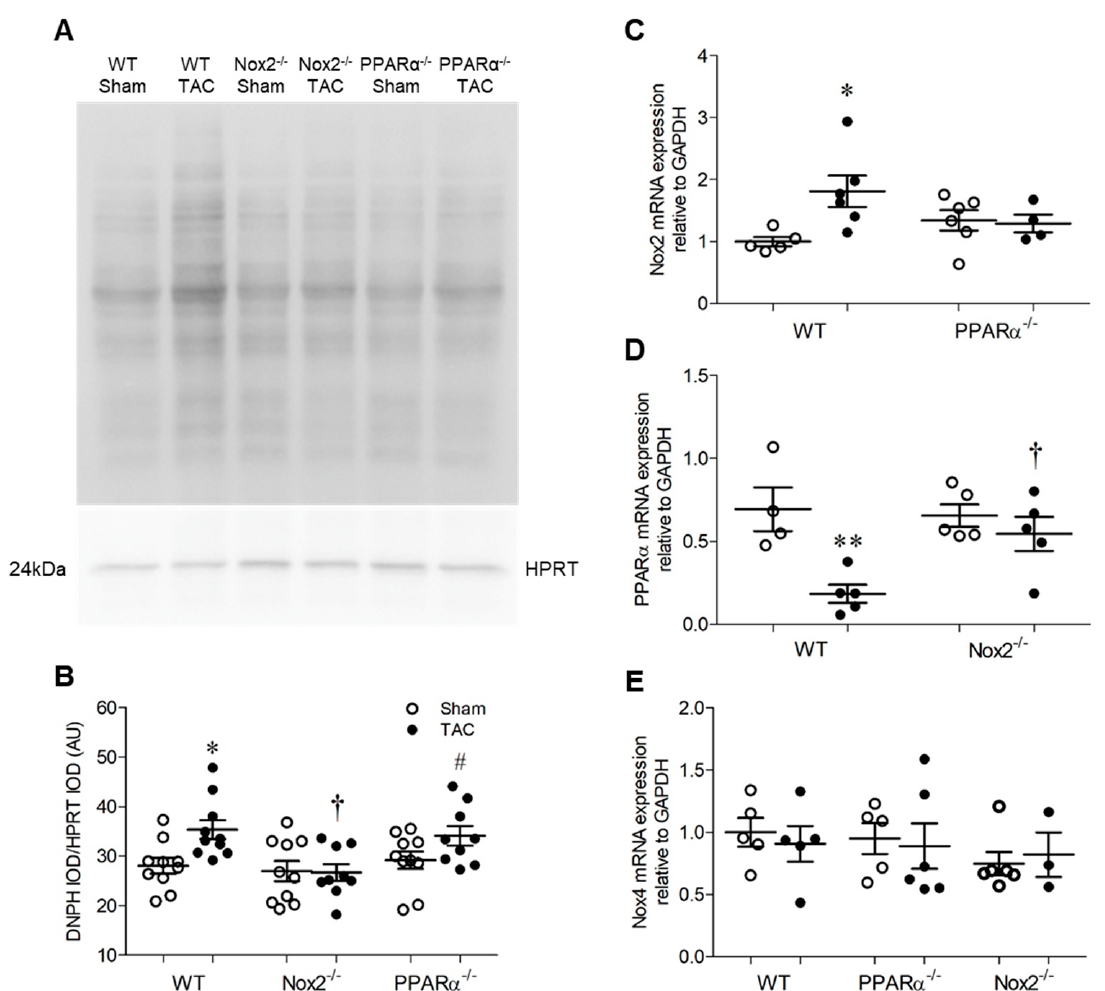
Figure 4. Pressure overload is associated with altered myocardial redox status and PPAR α expression. ( A , B ) Myocardial protein carbonylation is elevated in WT animals following pressure overload, an e ff ect that is prevented in the absence of Nox2 but unaltered in the absence of PPAR α . Representative blot is shown in ( A ) and mean data in ( B ) ( N = 8–10). ( C ) Nox2 transcript levels are elevated by pressure overload in hearts of WT animals but normalised in the absence of PPAR α . ( D ) PPAR α transcript levels are reduced by pressure overload in hearts of WT animals but normalised in the absence of Nox2. ( E ) Nox4 transcript levels are unchanged by pressure overload ( N = 3–6). Mean ± SEM; * p < 0.05, ** p < 0.01 vs. corresponding sham, † p < 0.05 vs. corresponding WT, and # p < 0.05 vs. corresponding Nox2 − / − .